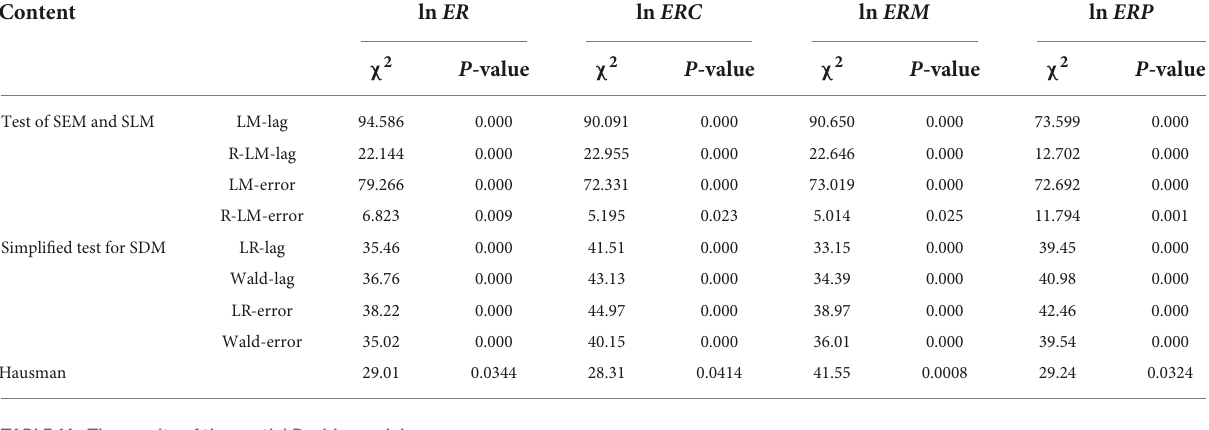
TABLE 11 The results of the spatial Durbin model.